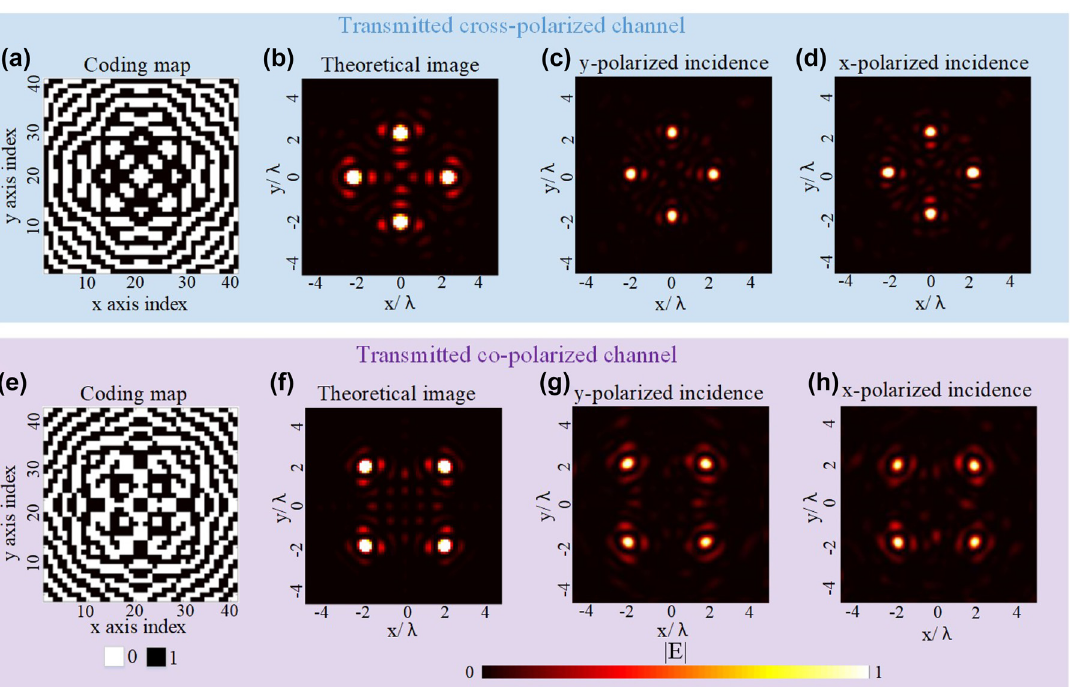
Figure 3: Coding maps and theoretical and simulated results of the electric field intensity distributions: (a) – (d) cross-polarized transmission channel projecting the image of a “ rhombus ” and (e) – (h) co-polarized transmission channel projecting the image of a “ square ”